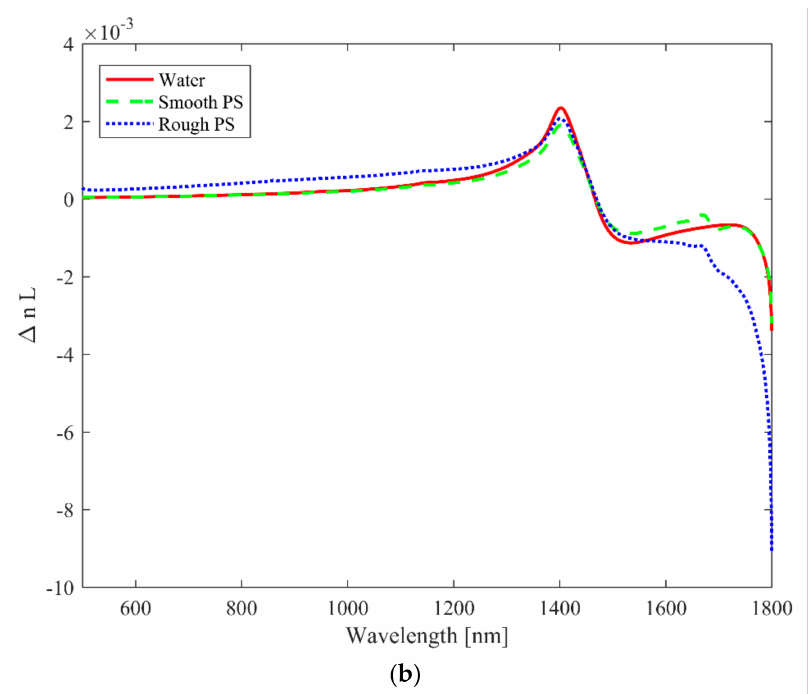
Figure 2. Product of imaginary / real refractive index for smooth and rough macroplastics, and water. ( a ) attenuation length ( kL ); ( b ) Change in optical path length ( ∆ nL